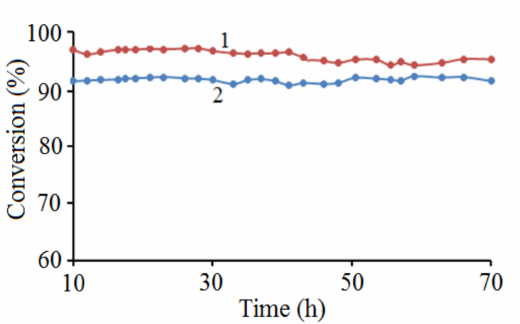
Figure 16. Influence of the duration of the experiment on the stability of the catalyst. Note: 1—CO 2 conversion, %, 2—CH 4